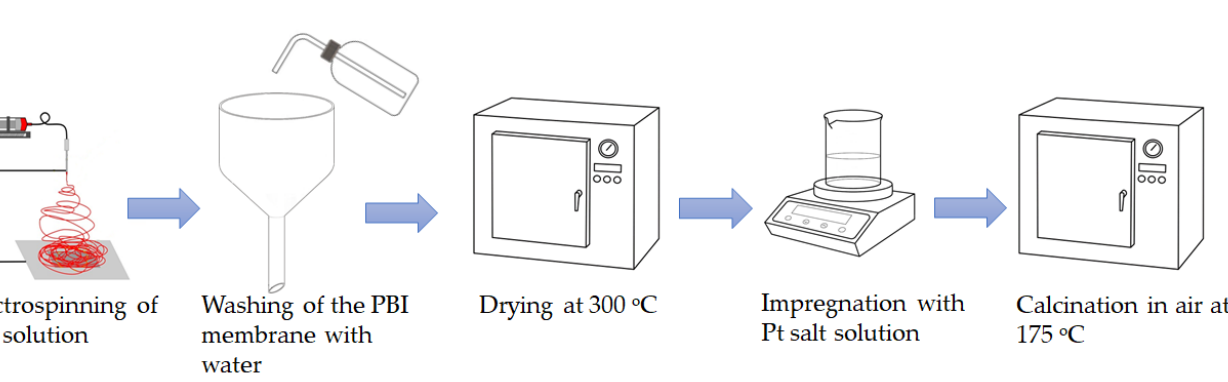
Figure 2. Overall scheme of the preparation of the electrospun catalysts.